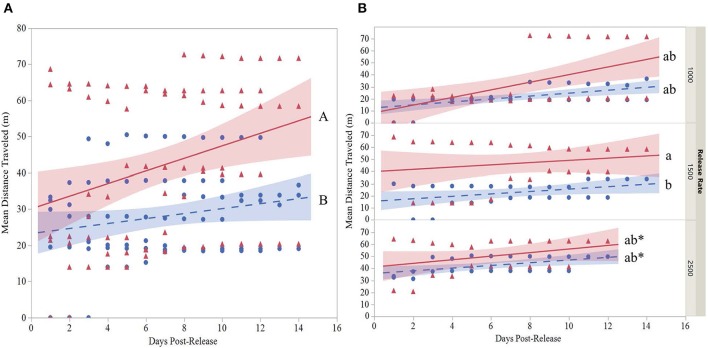
(A) Overall regression with 95% confidence interval bands of the mean distance traveled (MDT) for two strains (, GA; , OX4319L) of P. xylostella and (B) regression with 95% confidence interval bands at three release rates (1,000, 1,500, 2,500 males of each strain) in a 2.3 ha cabbage field (7 m traps excluded). MDT calculated according to Morris et al. (1991). Cumulative MDT analyzed with a mixed model where MDT is the response variable; strain, release rate and days post-release are fixed variables and release number is a random variable. *Last day observations were made at the 2,500 release rate. Overall strain lines with different capital letters (panel A) are significantly different as determined by a two-sample t-test, P < 0.001. Lines that do not share the same small letter(s) (B) are significantly different as determined by Tukey's HSD test, HSD0.05,6 = 2.89.